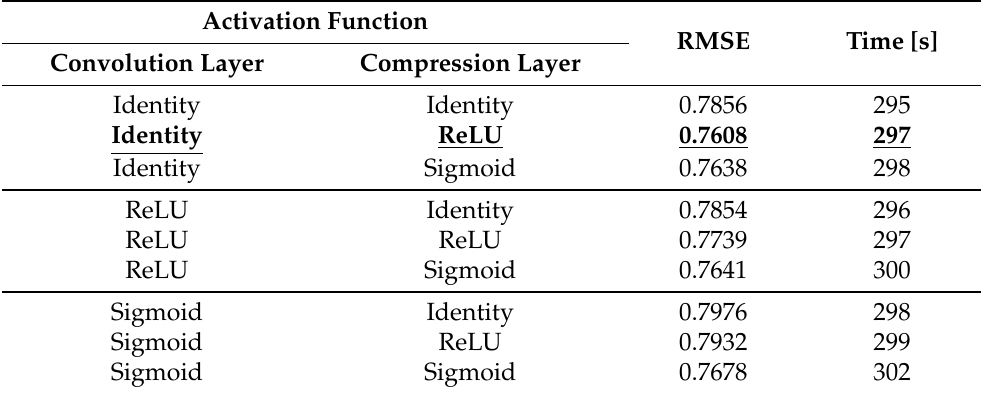
Table 3. Performance of kNN-Content model with different activation functions of the Convolution and Compression layers in the